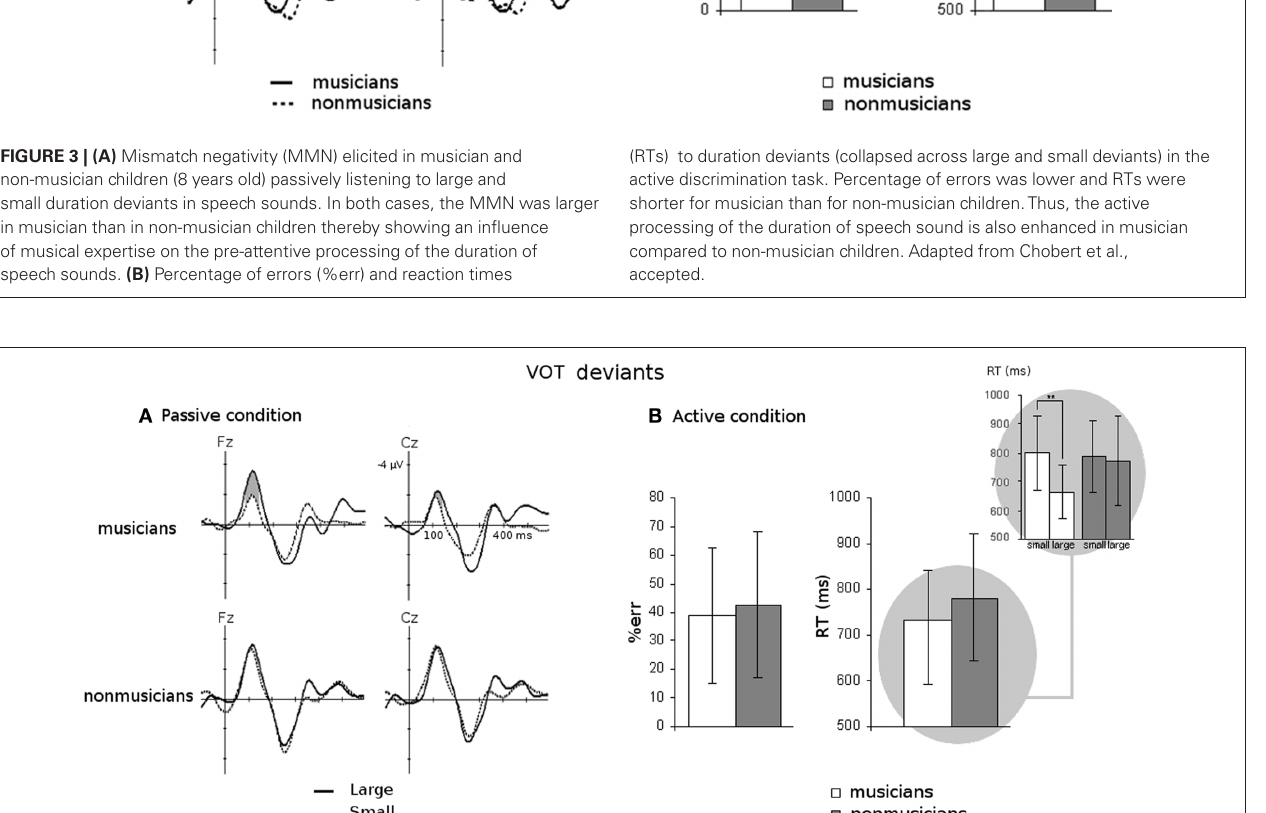
Figure 4 | (A) Mismatch negativity (MMN) elicited in musician and non- musician children (8 years old) passively listening to large and small deviants in voice onset time (VOT). The MMN was larger to large than to small VOT deviants only in musician children. The finding of no difference for large and for small VOT deviants in non-musician children suggests that they did not pre-attentively hear the difference between large and small VOT deviants.